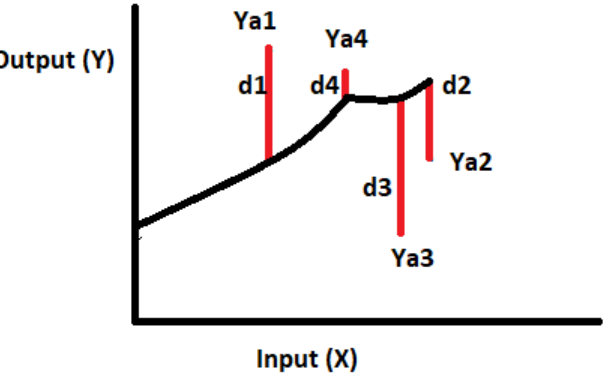
Figure 6. Distance between actual output (Ya) and predicted output